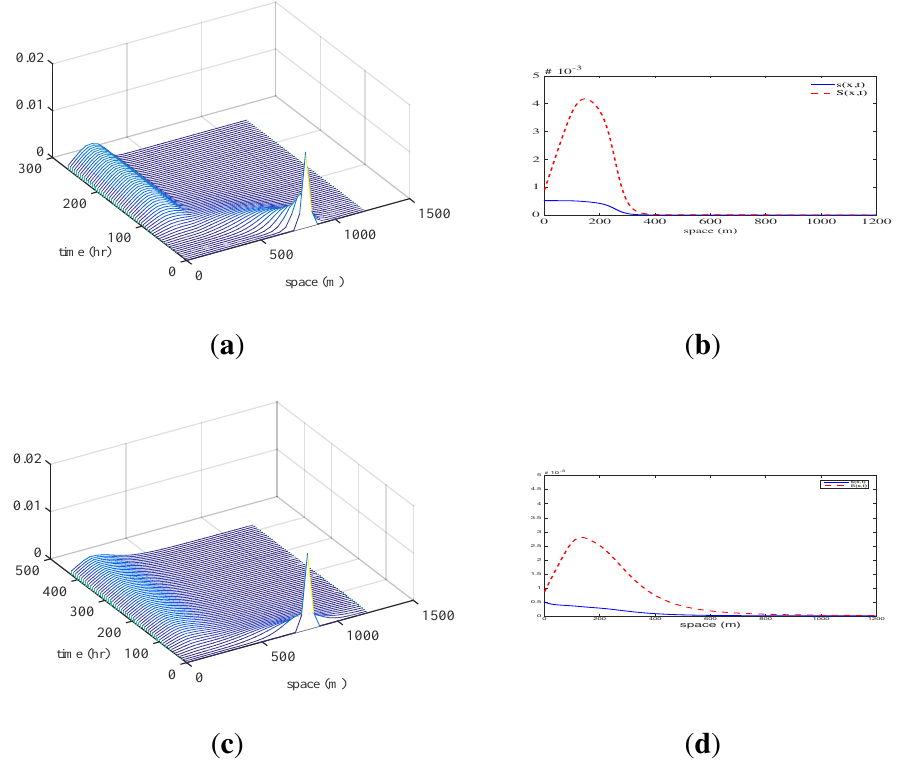
Figure 7. ( a )–( c ): S ( x, t ) , ( b )–( d ): the cross section of S at the final time; ( a ), ( b ) used Equation (43) dispersion in the calculation, ( c ), ( d ) computed using Equation (36) dispersion.